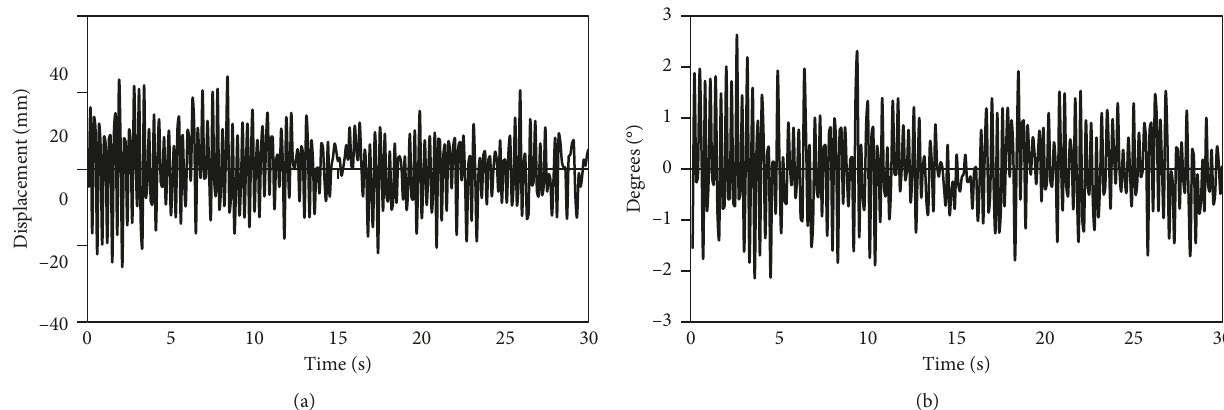
Figure 4: Time history responses for CM1, θ � 0 ° , 0.5(D), at 15m/s: (a) vertical vibration; (b) torsional